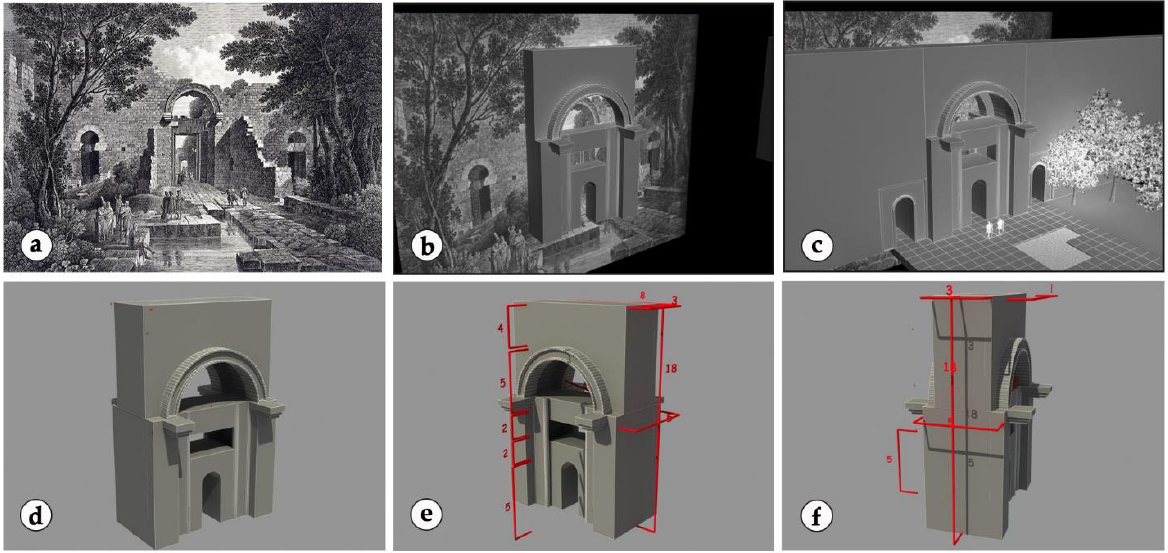
Figure 13. An animation about the Beroea (Medina) Gate: ( a ) Cassas ’ engraving of the Beroea gate, ( b , c ) modeling of the 3d gate from the engraving ( d – f ) Animation frames showing the dimensions of the Gate .